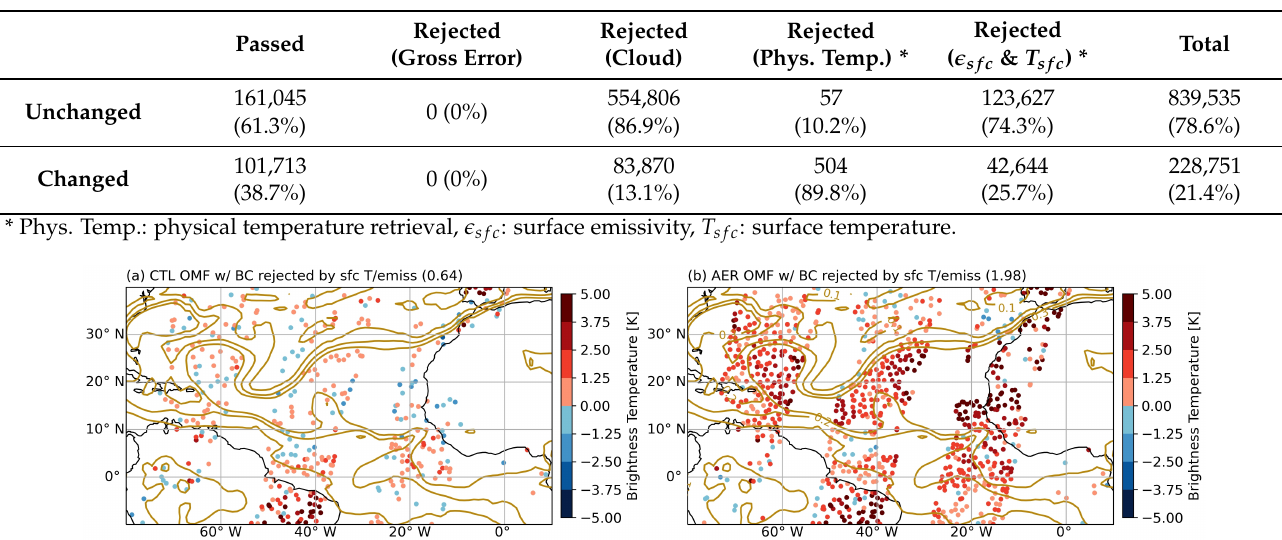
Table 3. The changes in the QC results in AER at 10.39 µm of IASI onboard MetOp-A with respect to CTL. The percentage relative to the counts in CTL is indicated in the parenthese.